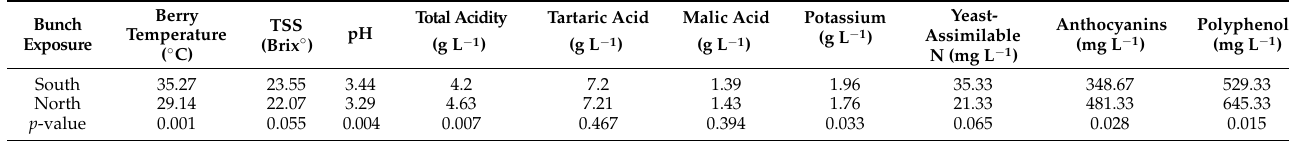
Table 2. Effect of bunch exposure on berry temperature and quality parameters of the must: total soluble solids (TSS), must pH, titratable acidity, tartaric acid, malic acid, yeast available nitrogen, total anthocyanins, and total polyphenols collected in 2020 and for south- or north-exposed bunches. Data are means (n = 3). Data were compared with t -test.